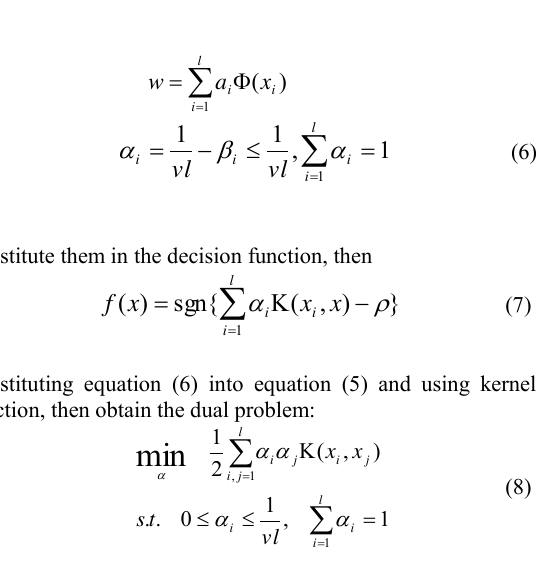
Figure 1 The one-class SVM